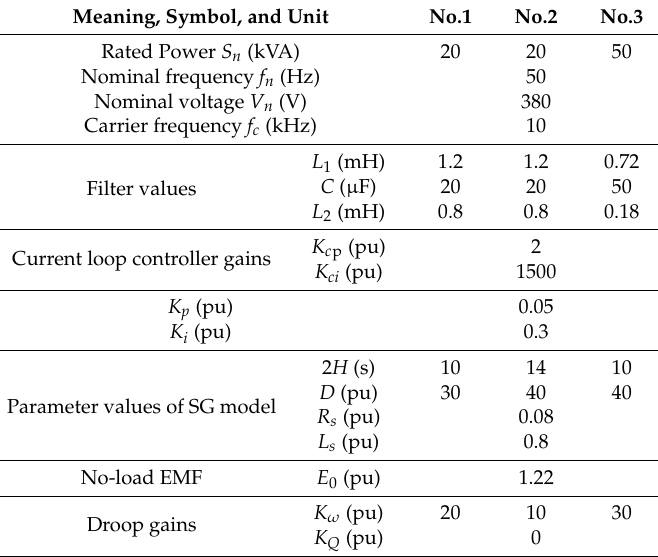
Table 3. Inverter Parameters of the Proposed PV